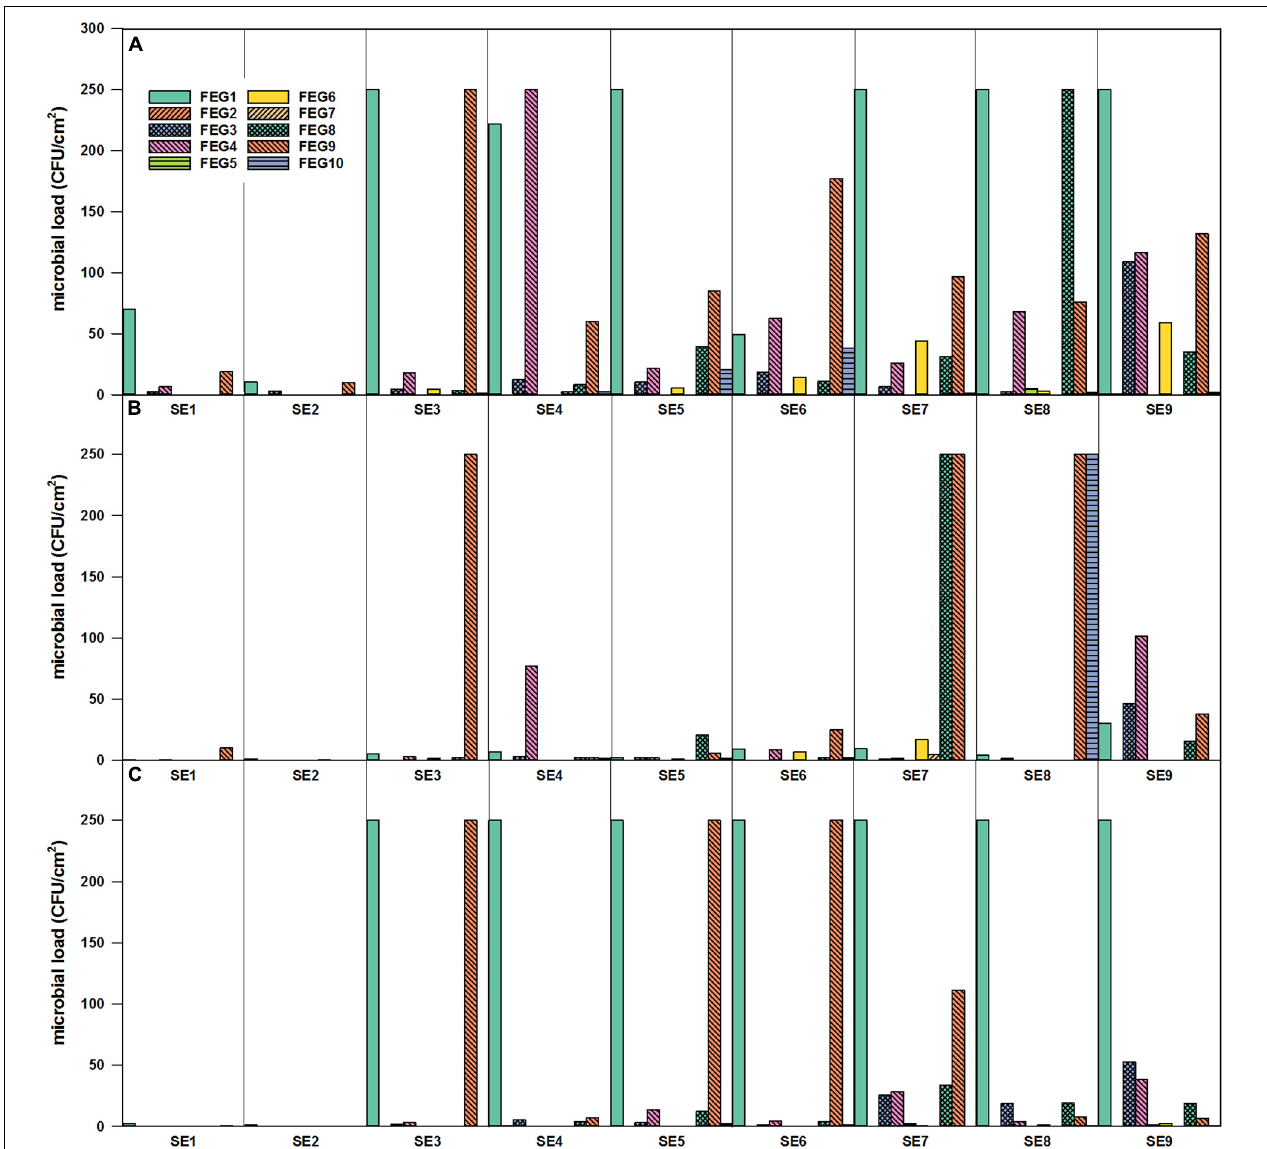
FIGURE 4 | Microbial load (CFU/cm 2 ) in the FEG compartment over time of operation. FEG1 – FEG10: different sampling positions inside the compartment. (A) Selective R2A, (B) R2A with heat shock, and (C) selective PDA, sampling period from January to November